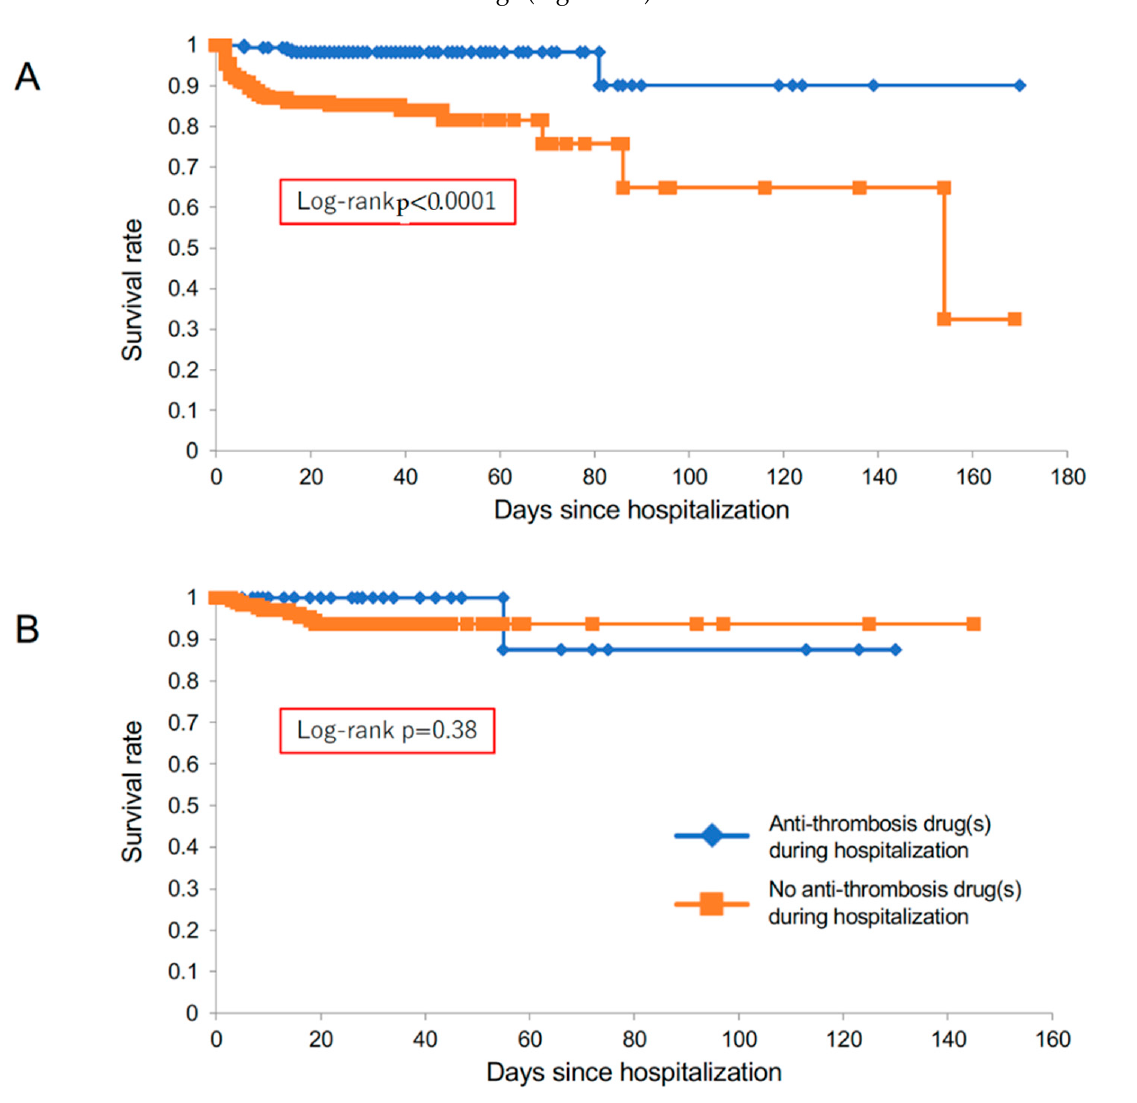
Figure 5. Kaplan–Meier curves of hospitalized patients with acute aortic dissection, in type A (panel ( A )) and type B (panel ( B )).